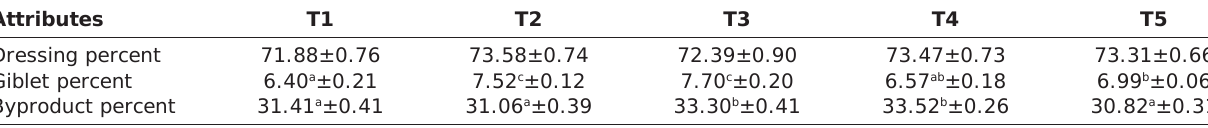
Table-7: Effect of dietary su pplement on carcass quality at 6 th week in